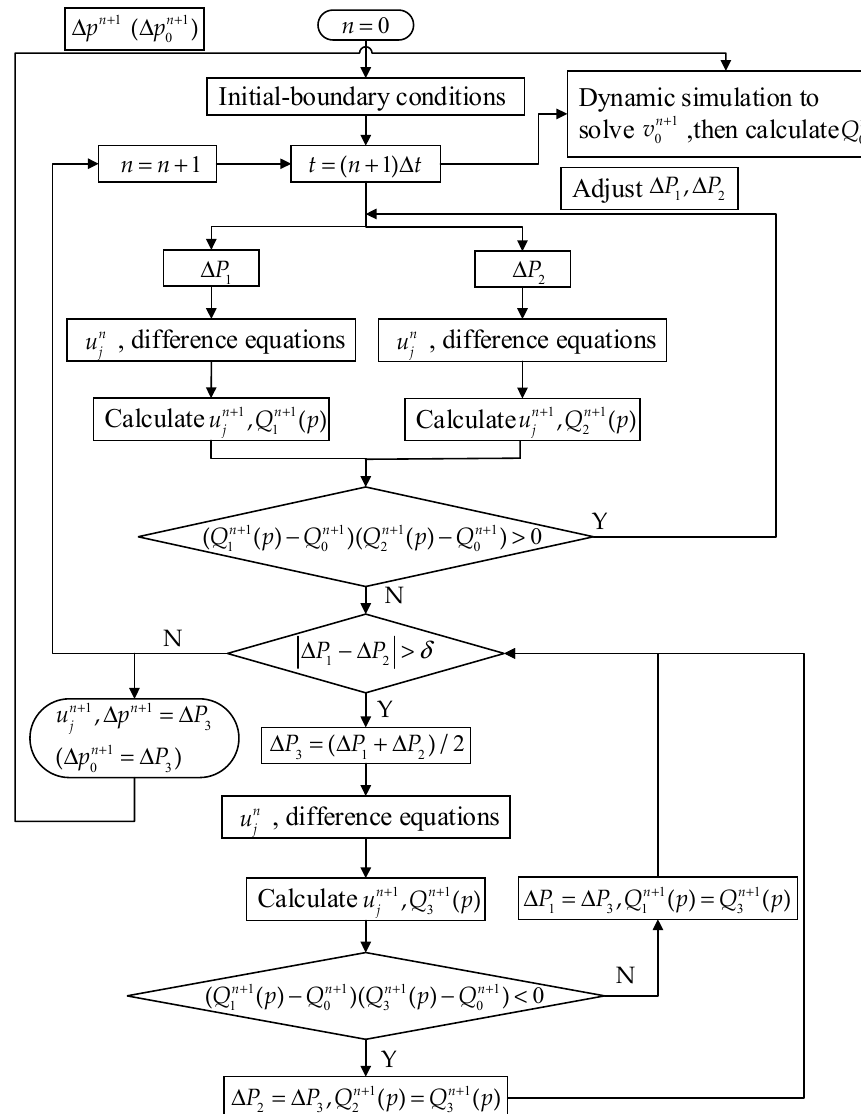
Figure 11. Unsteady numerical model flowchart.